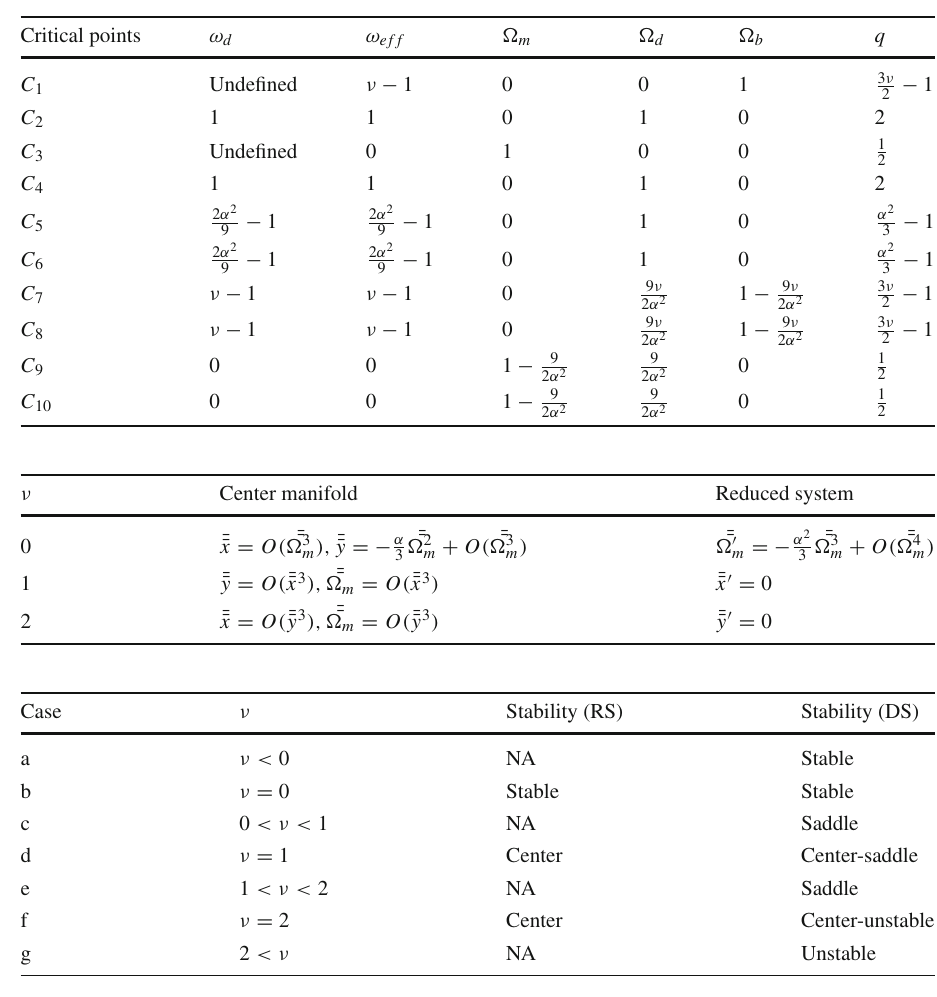
Table 2 Values of the different cosmological parameters at the critical points